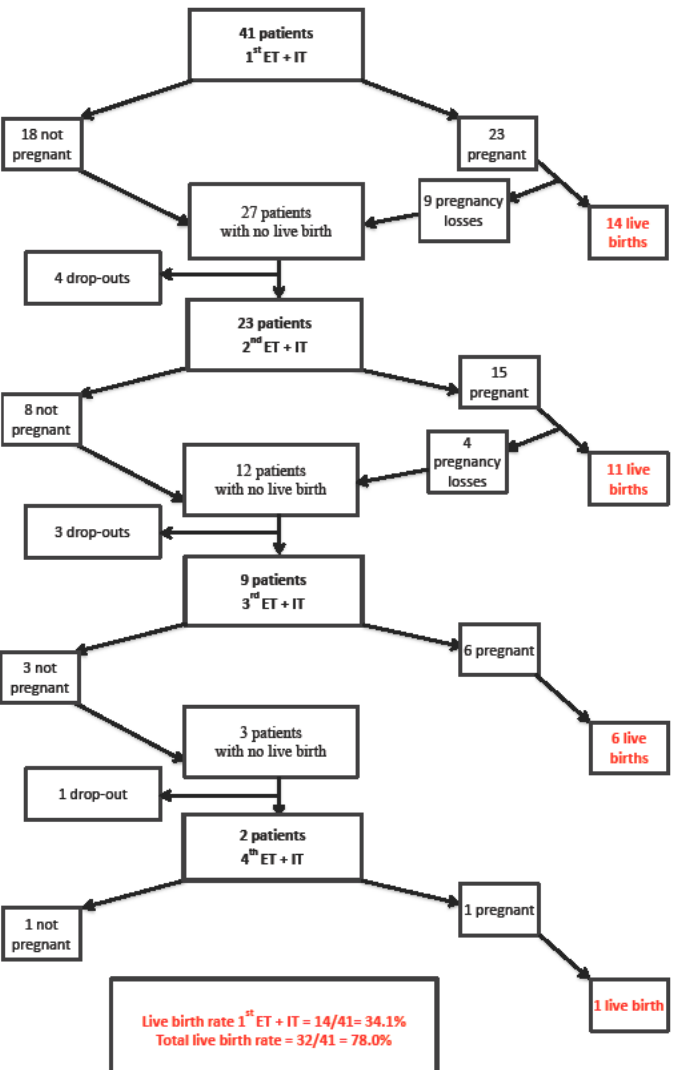
Figure 1. Outcome after first, second, third and fourth embryo transfer (ET) with immunotherapy (IT) with prednisone and intravenous immunoglobulin.